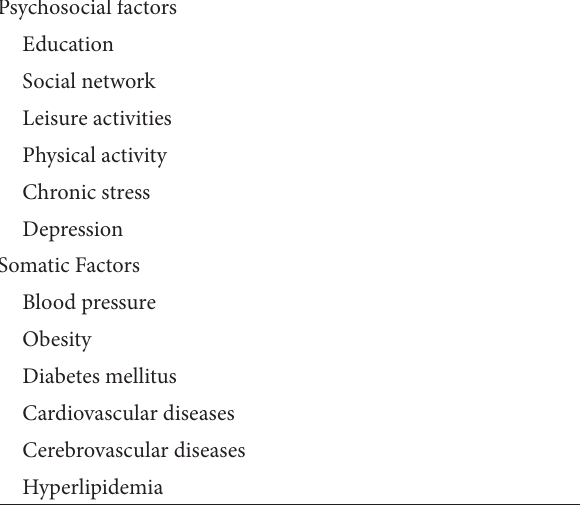
Table 1: Genetics and environmental risk factors associated with human AD